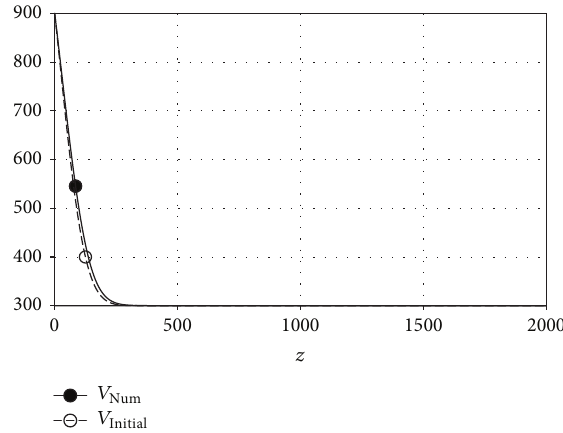
Figure 3: Initial approximation 𝑉 of BVP (19),